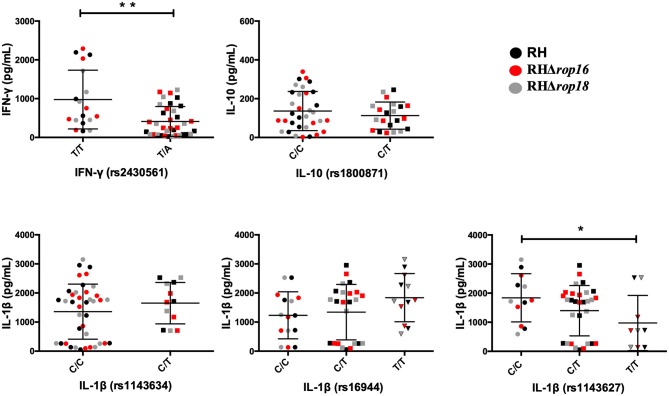
Cytokine production by PBMCs at 24 h post-infection with T. gondii RH (Black), RHΔrop16 (red), and RHΔrop18 (gray) was stratified by genotype of the following SNPs: IFN-γ (rs2430561), IL-10 (rs1800871), and IL-1β (rs1143634, rs16944, rs1143627). The cytokines levels were measured by ELISA. Results are represented by circles or square for individual data and bars are the mean ± SD; *p < 0.05, **p < 0.005. Mann-Whitney U test was performed.